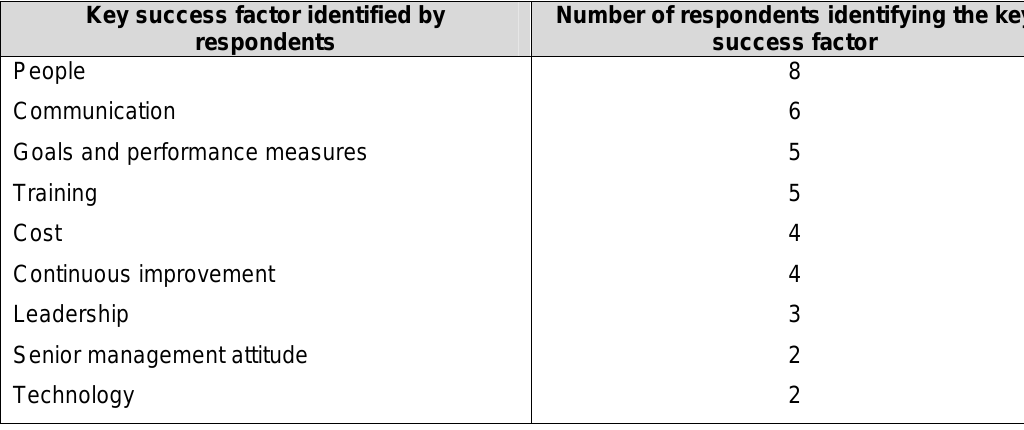
Table 1: Key success factors as identified by the respondents Key success factor identified